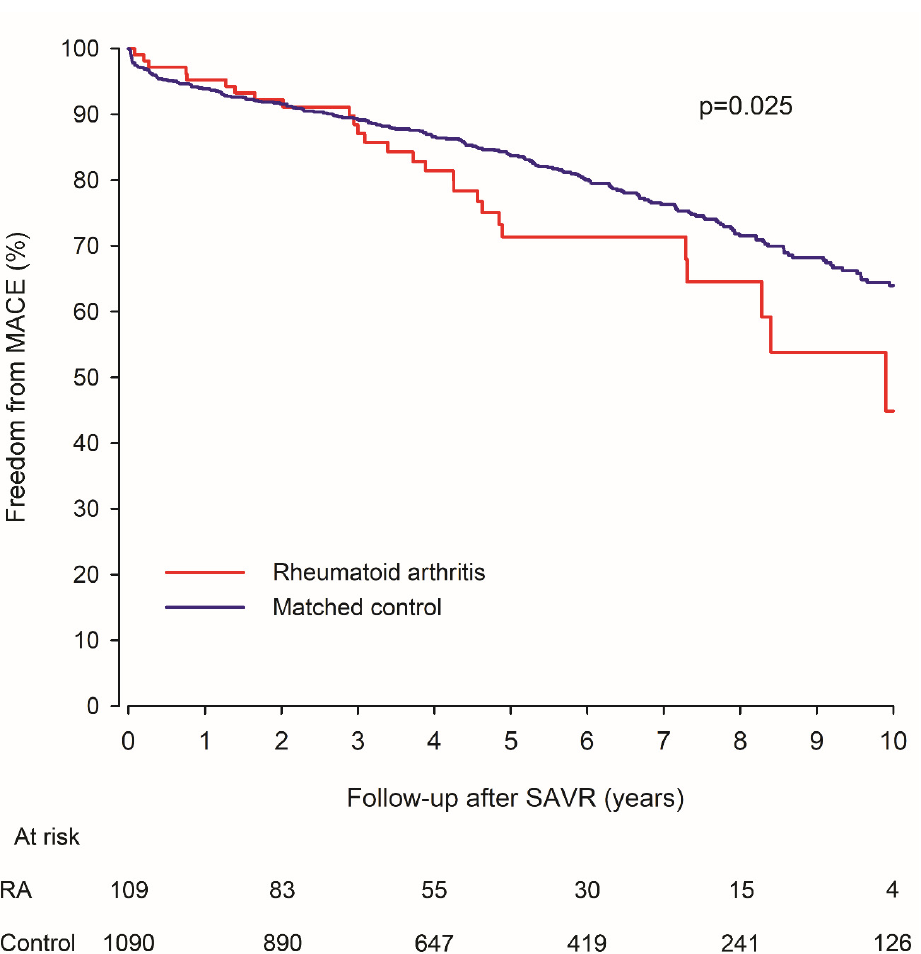
Figure 3. Freedom from major adverse cardiovascular event (MACE) in surgically treated aortic valve stenosis patients with rheumatoid arthritis and matched control patients. RA = Rheumatoid arthritis. SAVR = Surgical aortic valve replacement.